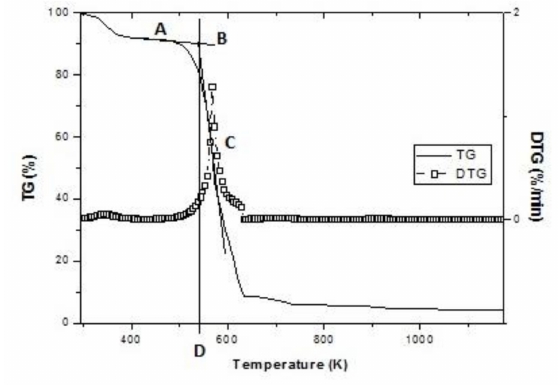
Figure 3. Ignition temperature ( T e ) definition sketch. (TG: thermogram; DTG: first derivative of the